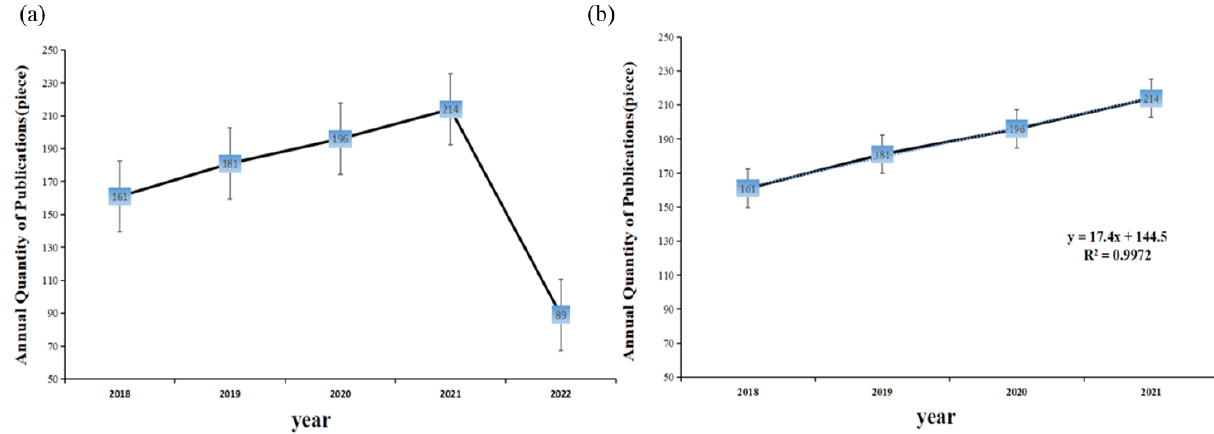
Figure 1. Annual number of publications ( a ) and publication trend line ( b ).